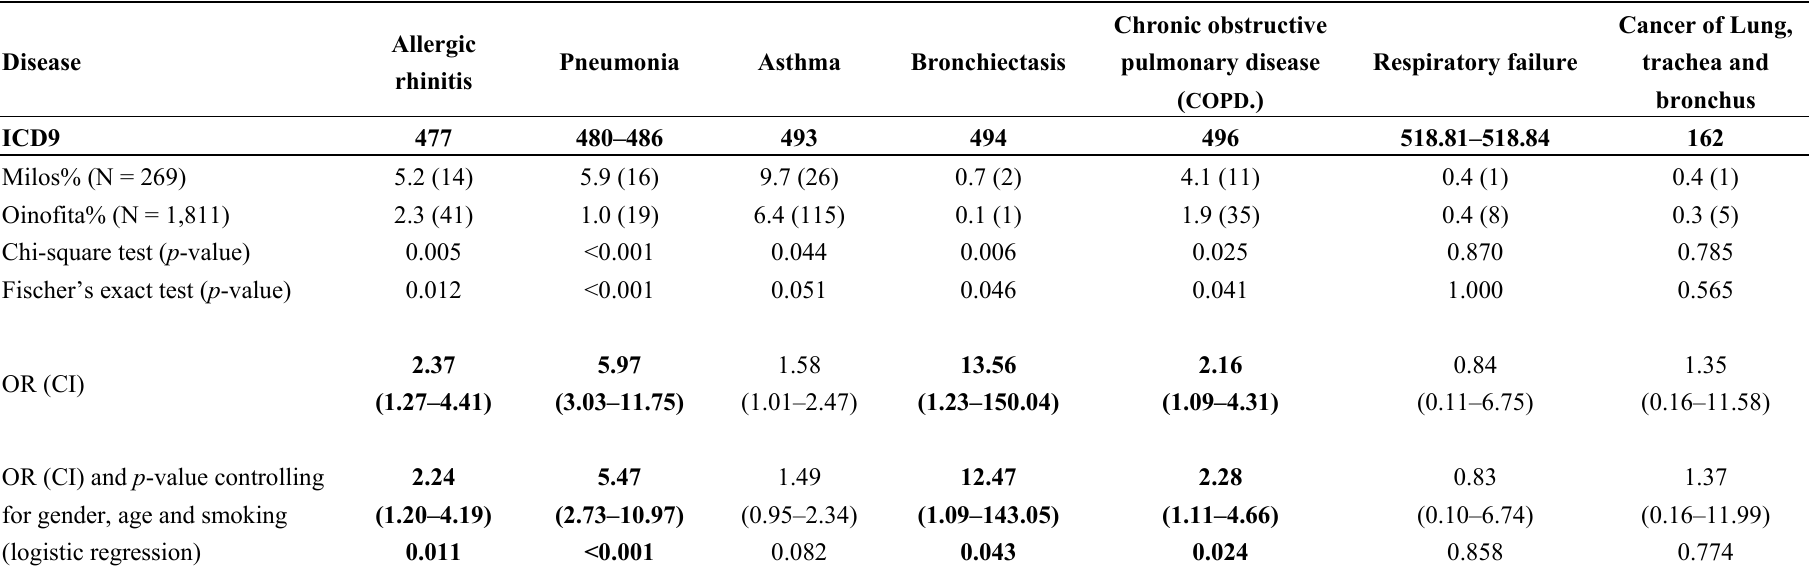
Table 3. Respiratory disease related morbidity in Milos compared to